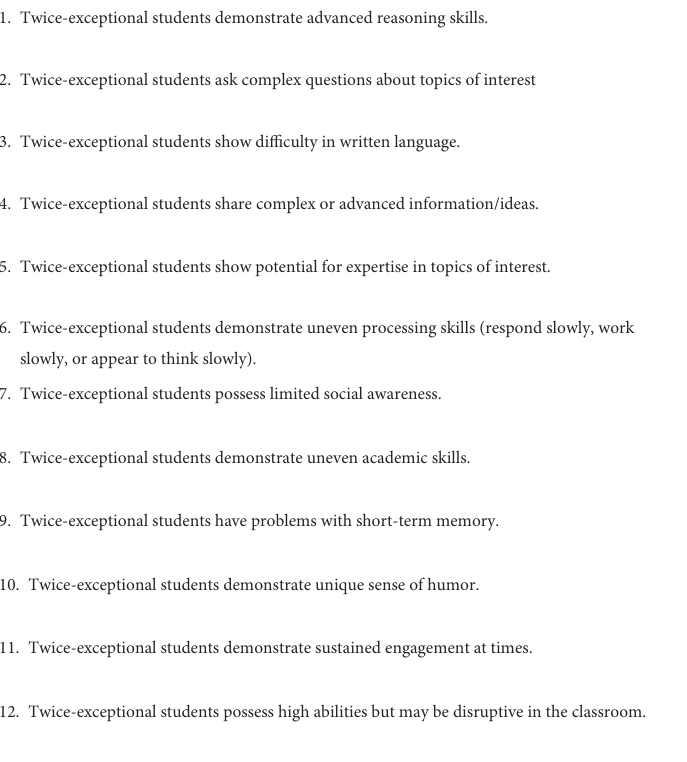
Pre Post Experimental Control Experimental